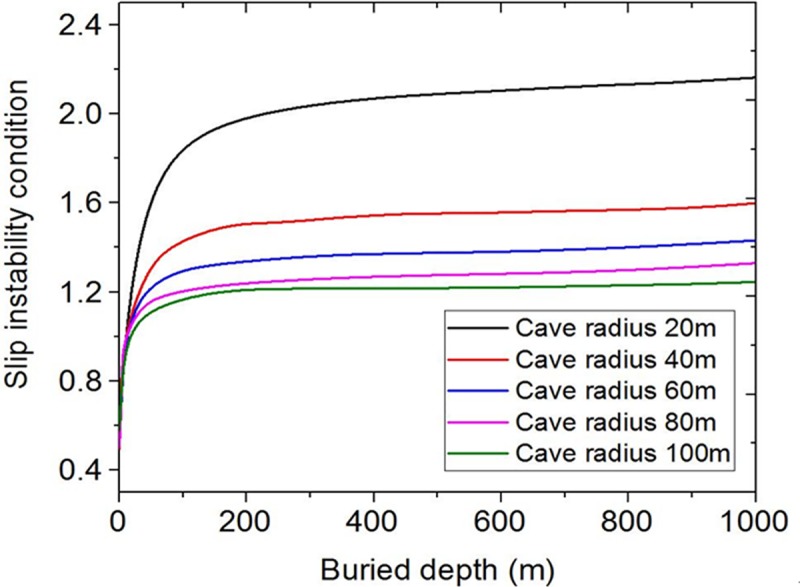
Influence curves of different cave radius.